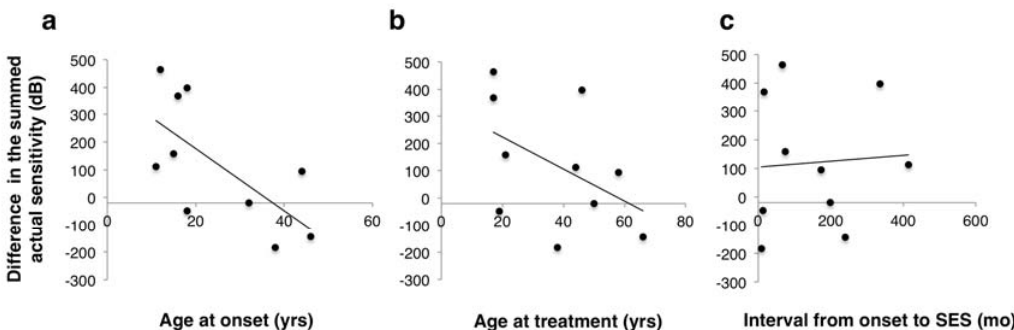
Figure 5. Scatter plots of the difference in summed actual sensitivity between baseline and 18 weeks as a function of: ( a ) age at onset ( r = − 0.67, p = 0.03); ( b ) age at treatment ( r = − 0.46, p = 0.18); and ( c ) the interval between disease onset and skin electrical stimulation ( r = 0.06, p = 0.86).